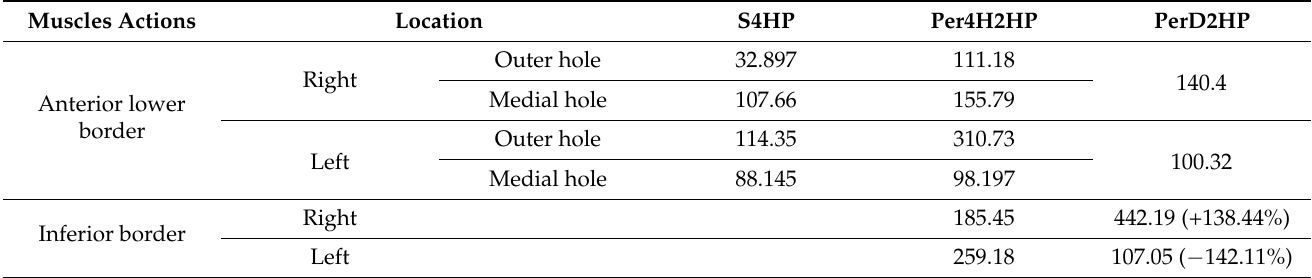
Table 4. The MaxVMS of screws in three fixation groups with mandibular symphysis fracture (Unit: MPa). Muscles Actions